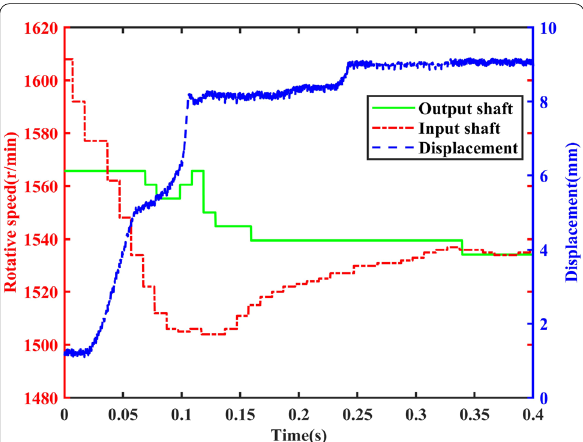
Figure 9 The speed of the shaft and the displacement of the